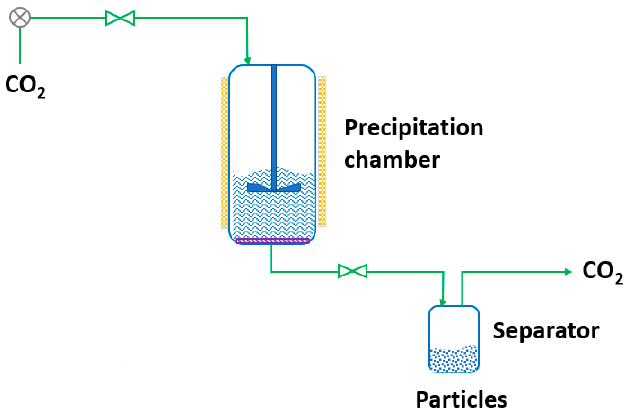
Figure 11. Gaseous antisolvent (GAS)